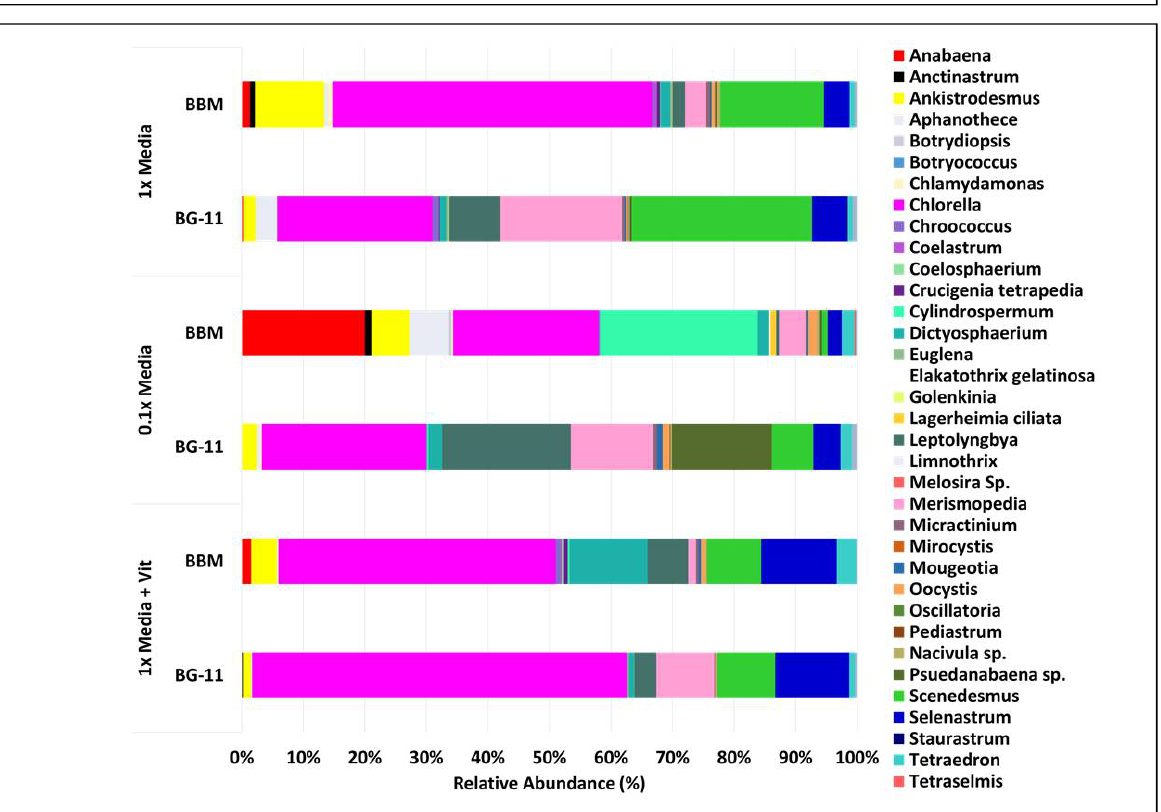
Figure 4. Species relative abundance graph comparing between 1 × Media, 0.1 × Media and vitamin-enriched media of BBM and